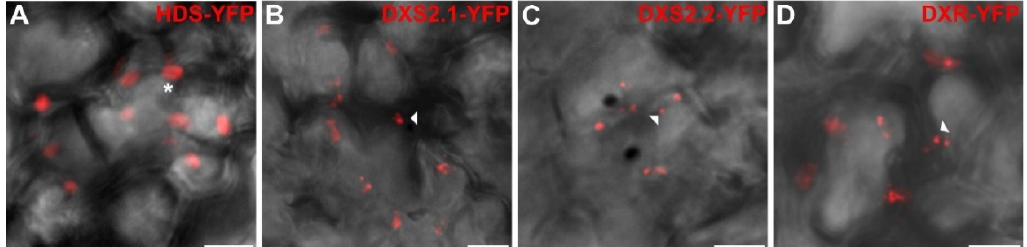
Figure 6. Subcellular localization of HDS-YFP, DXS2.1-YFP, DXS2.2-YFP and DXR-YFP fusions in cells of young C. roseus leaf. Young C. roseus leaves were transiently transformed with plasmids expressing HDS ( A ) and both DXS ( B , C ) and DXR ( D ) fused to the N-terminus of YFP as indicated on the top of each picture. The fluorescence emitted by YFP-fusion proteins was superimposed to cell morphology acquired using differential interference contrast. Arrowhead and star indicate punctuated and diffuse localization in plastids, respectively. Bar: 10 µm.